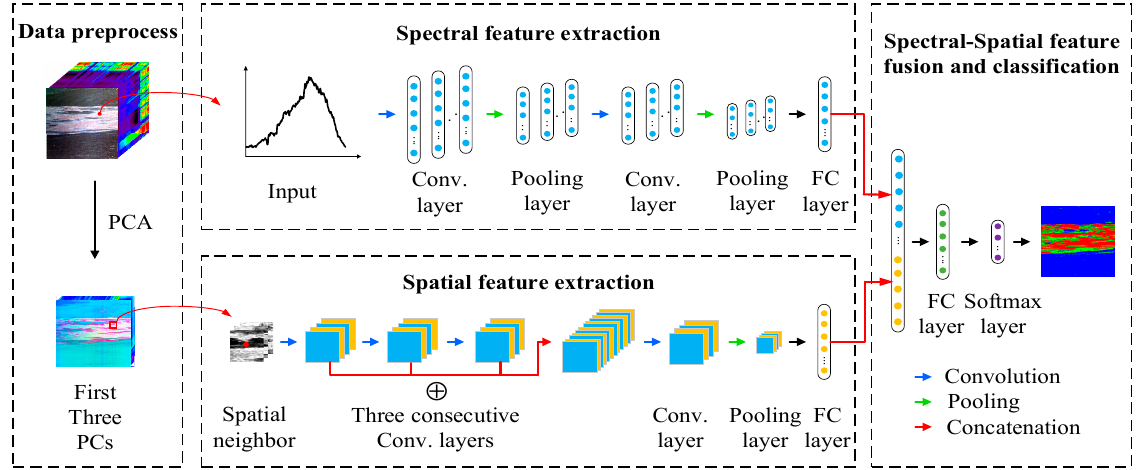
Figure 4. Architecture of the proposed model for oil detection, where Conv. is the abbreviation of convolution and FC refers to fully connected.